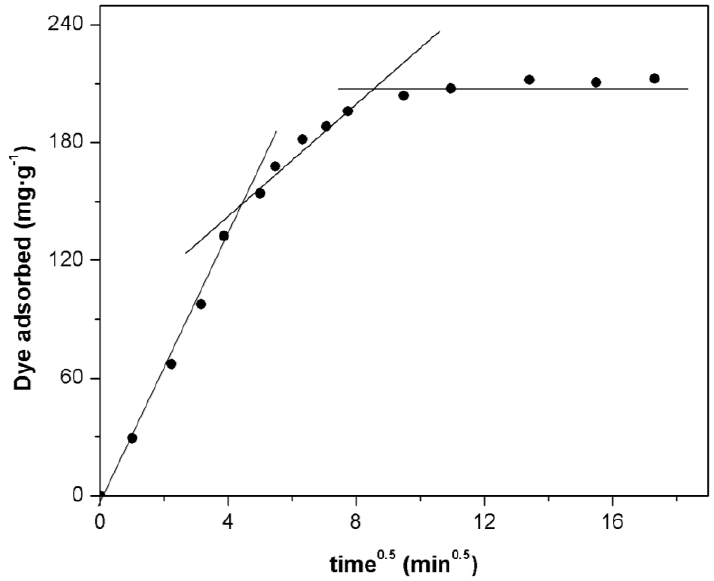
Figure 9. Intra-particle diffusion model plot of dye adsorbed over Fe(BTC). (Initial concentration: 50 mg·L −1 ; adsorbent mass: 10 mg; temperature: 308 K and pH